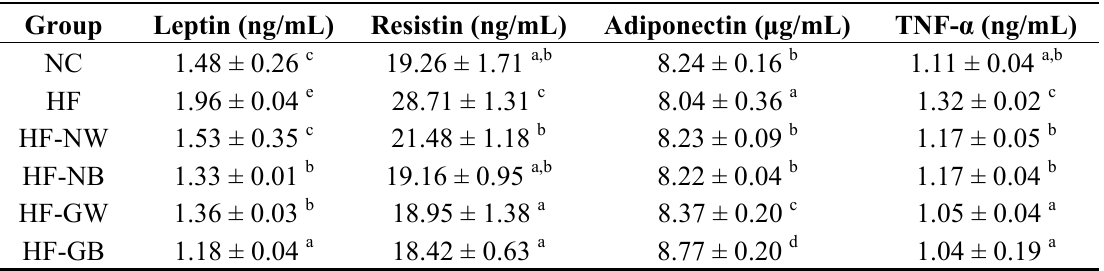
Table 6. Plasma adipokine concentrations in mice fed with high fat diet supplemented